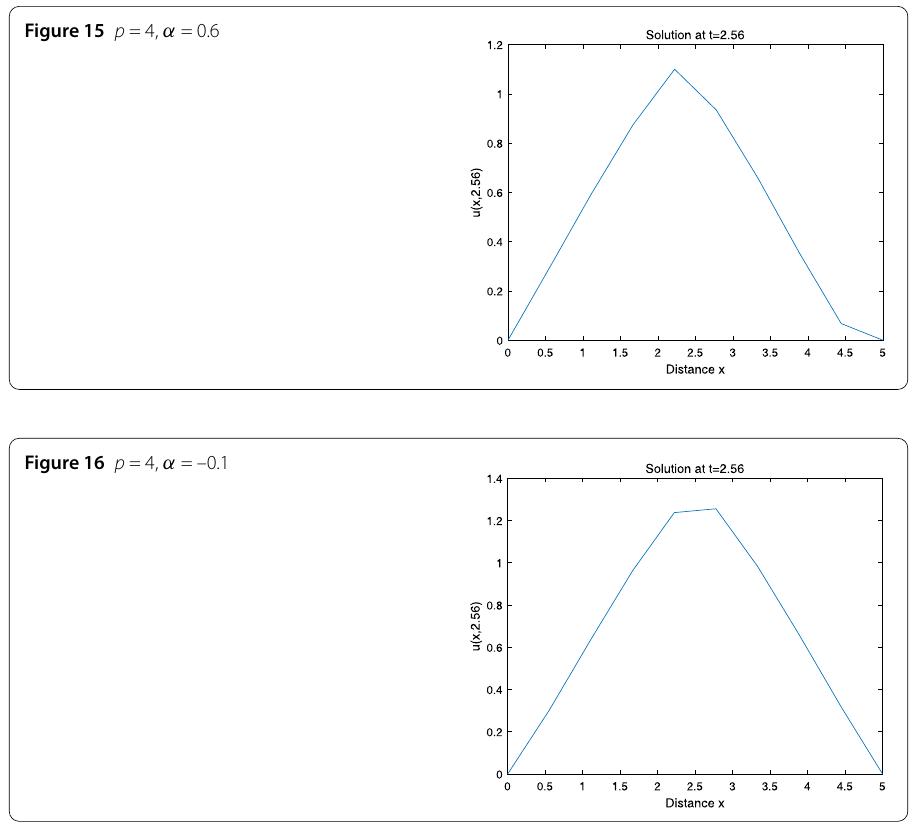
Figure 15 p = 4, α = 0.6